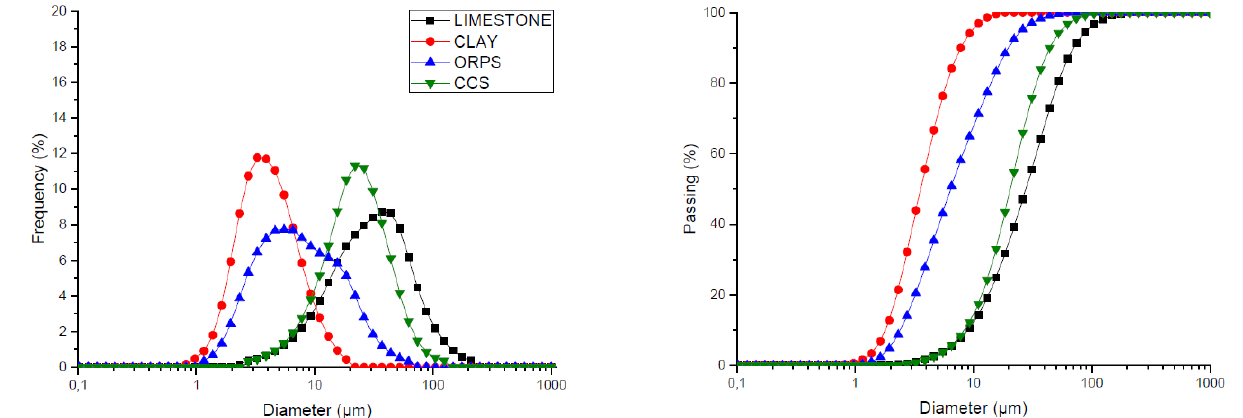
Figure 2. Granulometric distribution of the raw